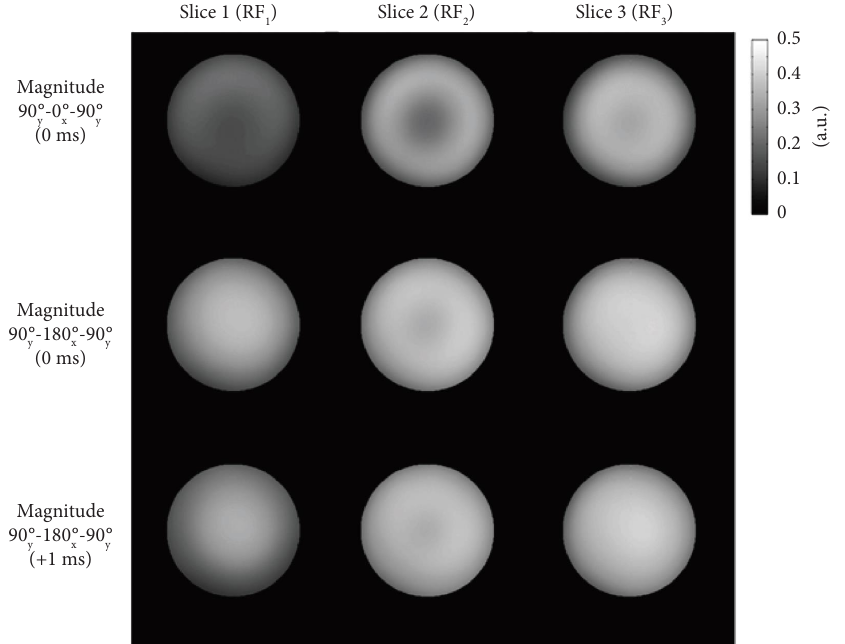
Figure 5: MR images for three echo signals, RF 1 (top row), RF 2 (centre row), and RF 3 (bottom row), obtained from the composite RF pulses in the phantom. Here, slices 1, 2, and 3 were obtained at diferent TEs.